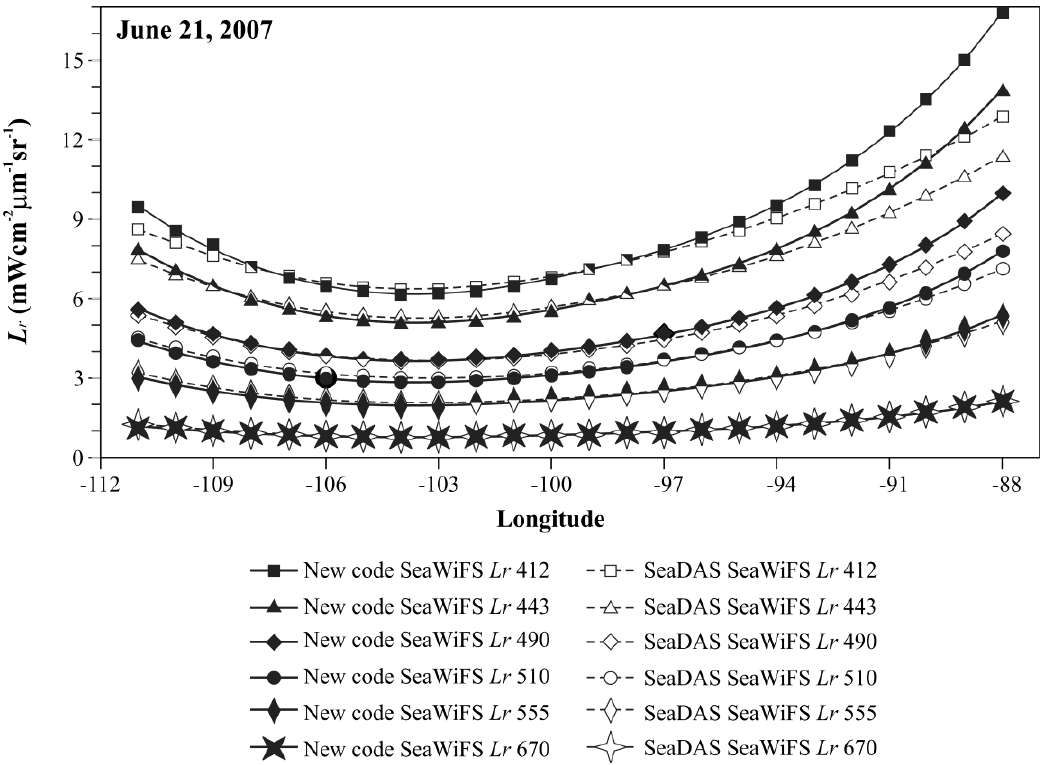
Figure 5. Comparison of Rayleigh path radiance for SeaWiFS bands 1 – 6 calculated by the new code and SeaDAS along a scan line of SeaWiFS data of 21 June